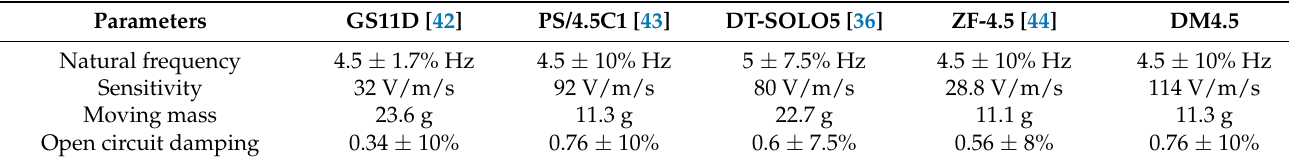
Table 2. Comparison of the sensitivity of different types of velocity